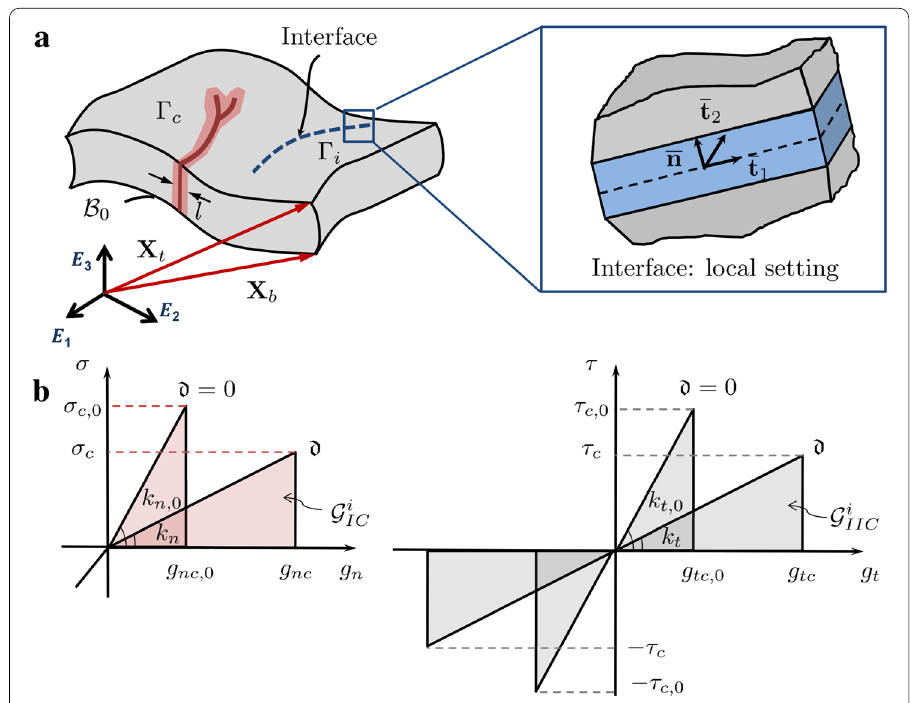
Fig. 3 a Generic shell body with cracks and prescribed interfaces; b traction–separation laws for fracture Modes I and